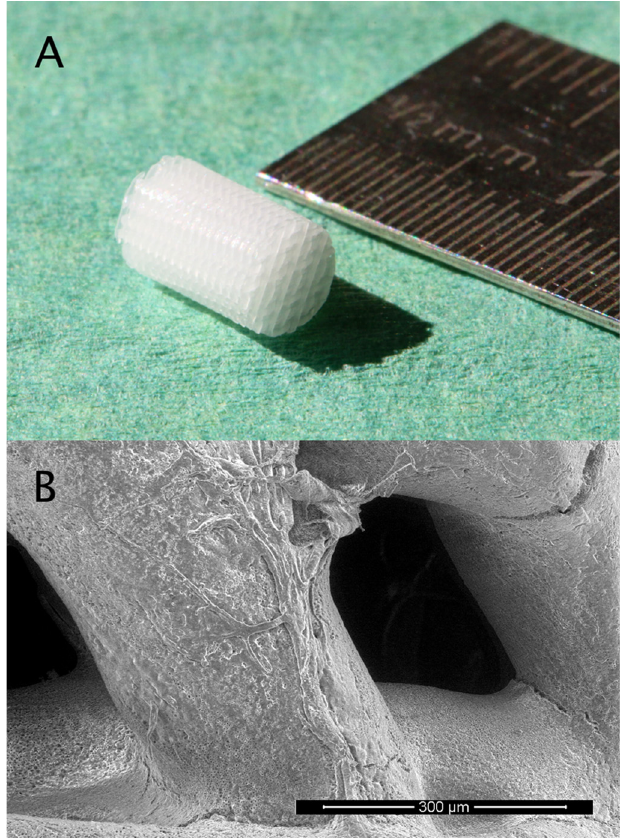
Figure 1. The scaffold, A: close up of the scaffold used for annulus fi brosus closure. B: SEM image of scaffold showing fi ber surface and the porous design. Cell migration and survival and thus new tissue formation, is dependent on the scaffolds design features. These scaffolds were made on a 3D printer that allows control of fi ber thickness, fi ber pattern and pore